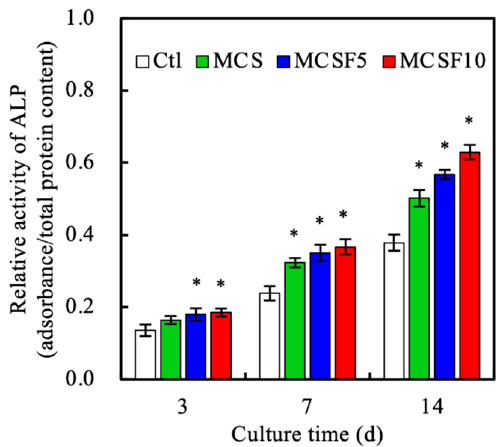
Figure 7. The alkaline phosphatase (ALP) activity of hWJMSCs cultured on different scaffolds for 3, 7, and 14 days. * indicates significant difference (p < 0.05) from Ctl group.